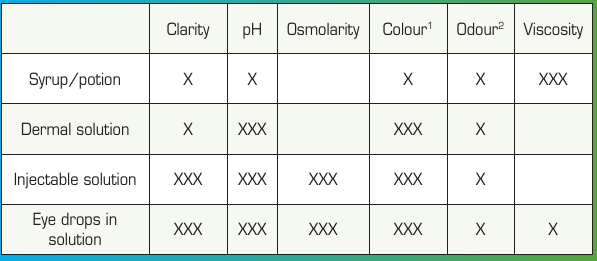
Table 7: Analyses recommended according to the dosage form of the solution (to be completed compulsorily by an analysis of the active ingredient and its degradation